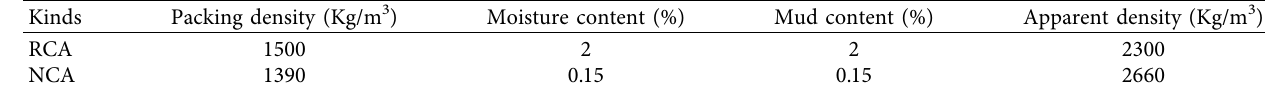
Table 3: Major performances of RCA and NCA.